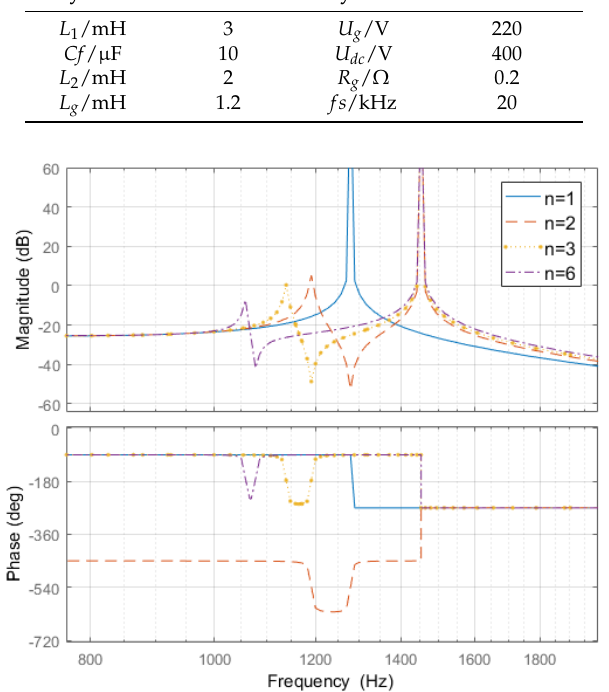
Figure 3. Bode diagram of G o_m . Table 1. Parameters of the HCGIs system.